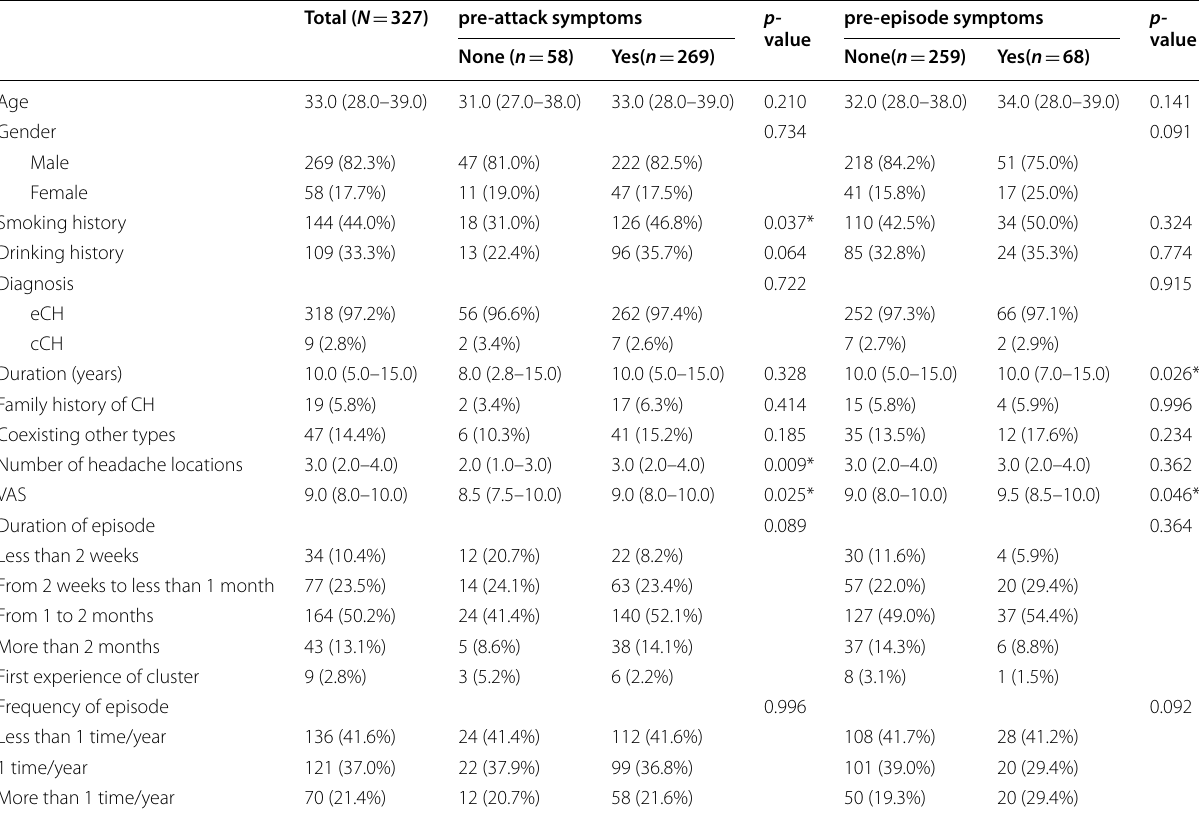
Table 1 Demographics and characteristics of patients with cluster headache, according to pre-attack and pre-episode